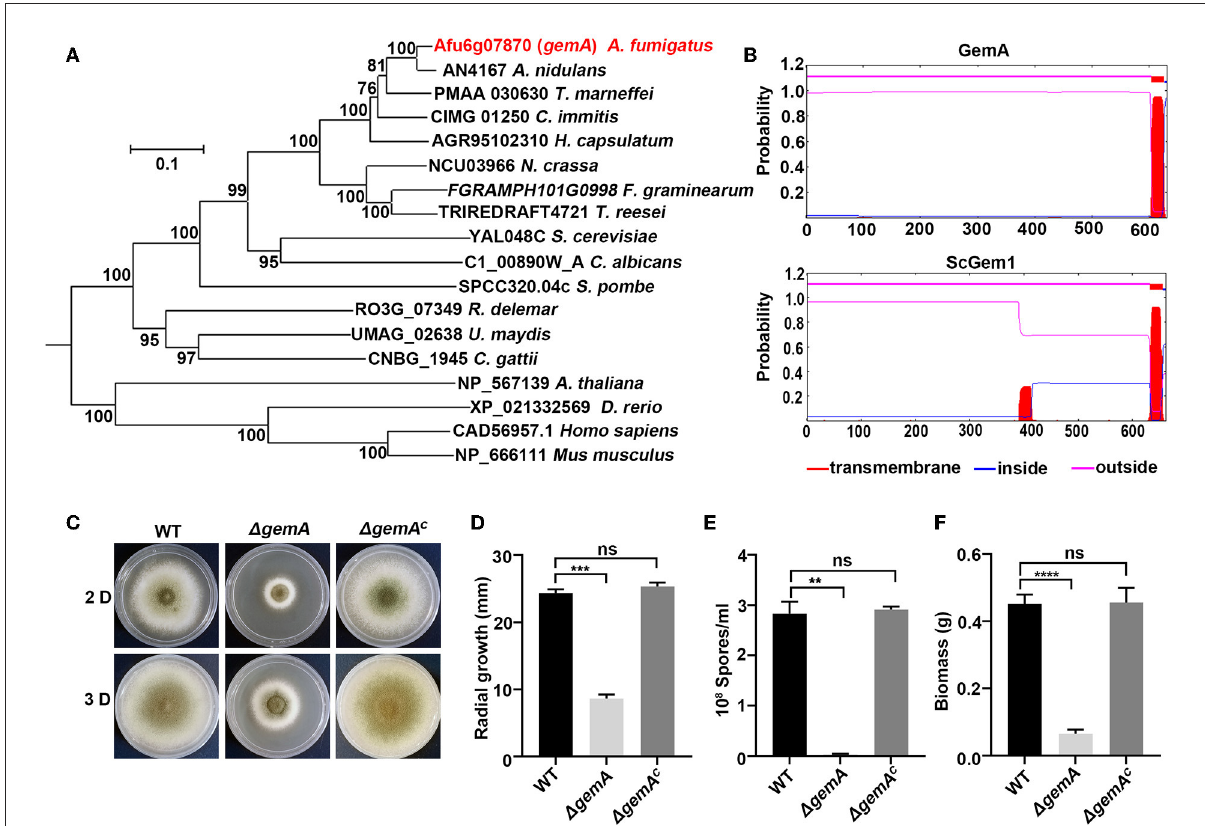
FIGURE1 Bioinformatic analysis of GemA and phenotypic characterization of the gemA mutant. (A) Phylogenetic analysis of GemA homologs from selected species. The MEGA 6 software was used to generate the phylogenetic tree. (B) The transmembrane domain prediction of GemA in A. fumigatus and ScGem1 in S. cerevisiae by using the TMHMM server v. 2.0 (http://www.cbs.dtu.dk/services/TMHMM-2.0). (C) Phenotypes of the indicated strains cultured on MM at 37 ◦ C for 2 or 3 days, and their quantitative data for (D) colony size (E) , conidia production (F) , and biomass. ns, P > 0.05; ** P < 0.01; *** P < 0.001; **** P <